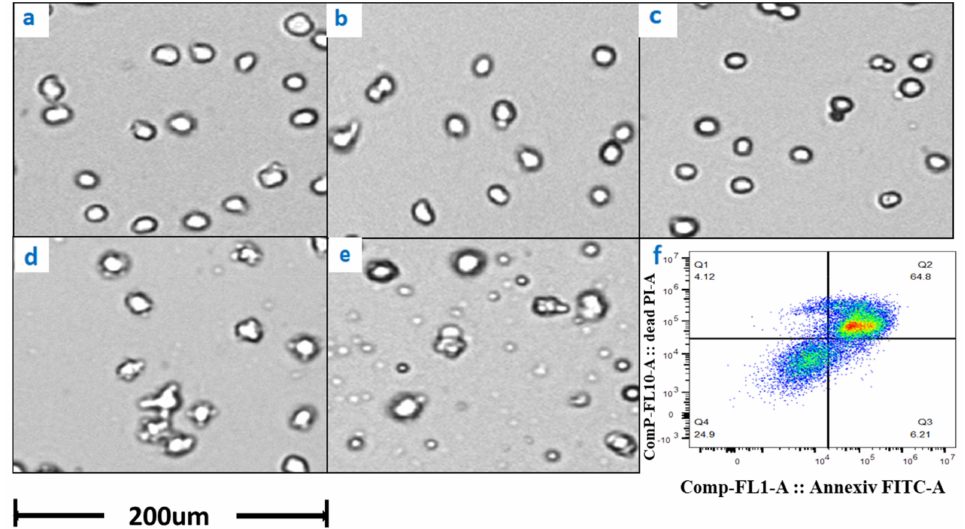
Figure 5. Changes in cell morphology with glucose withdrawal for ( a ) 0, ( b ) 4, ( c ) 8, ( d ) 12, and ( e ) 16 h in stationary phase. ( f ) represents the flow cytometry results of glucose withdrawal for 16 h, based on Annexin V